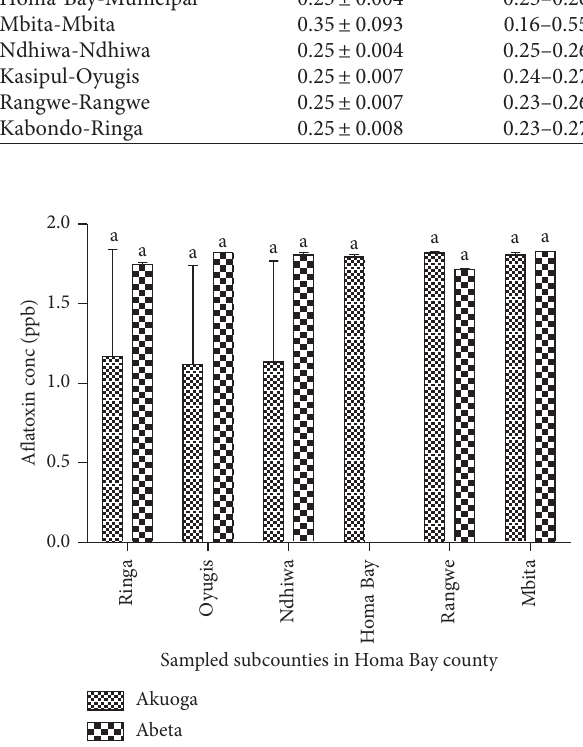
Figure 3: Aflatoxin quantification in Akuoga and Abeta types of processed cassava. Figures with same letter are not significantly different.